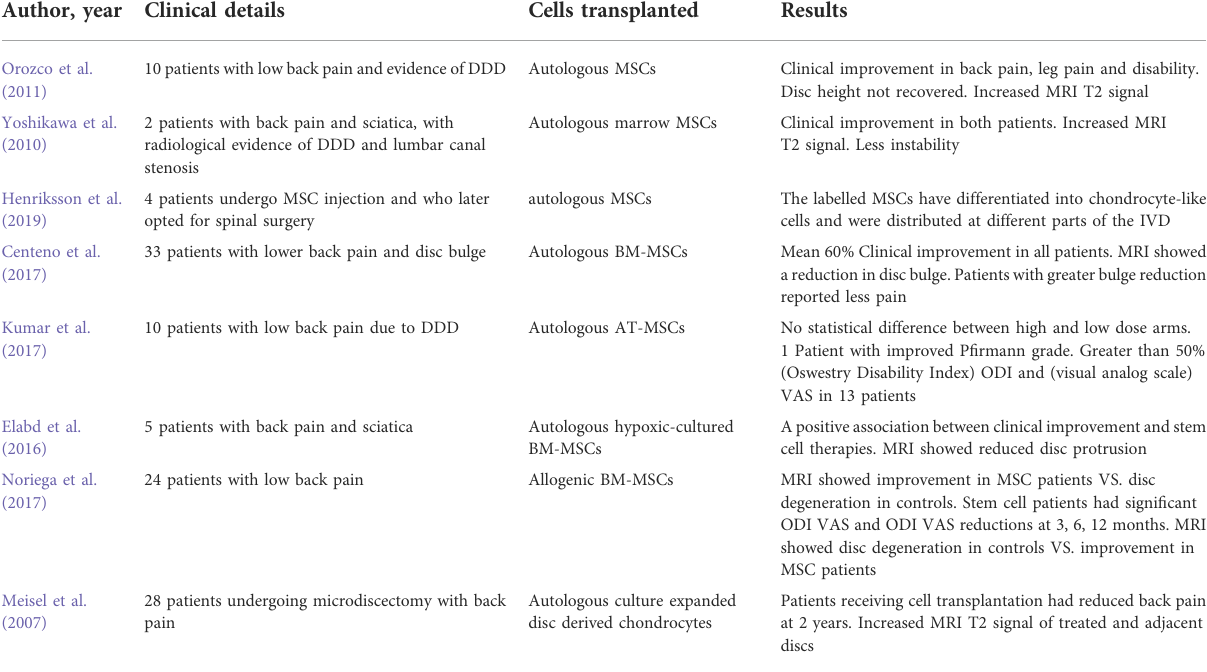
TABLE 2 Clinical studies utilizing cell-based therapies to treat chronic low back